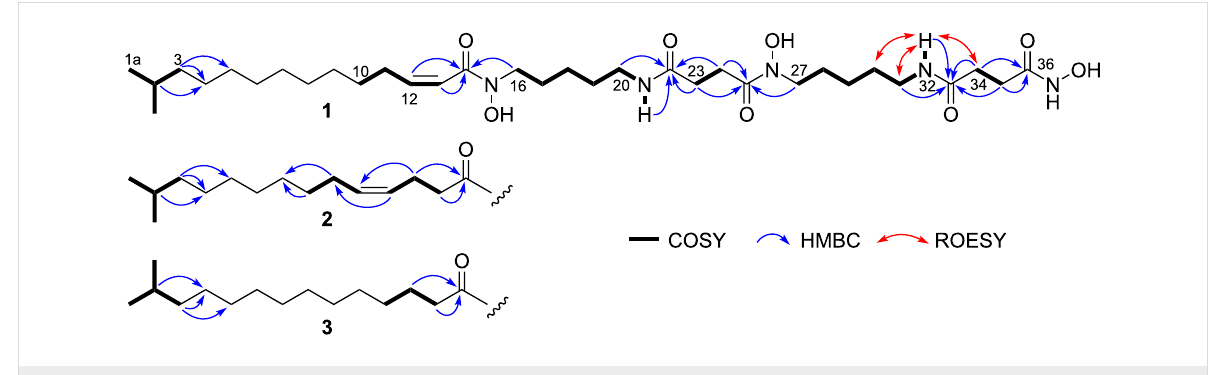
Figure 2: Key 2D-NMR correlations for 1 – 3 .